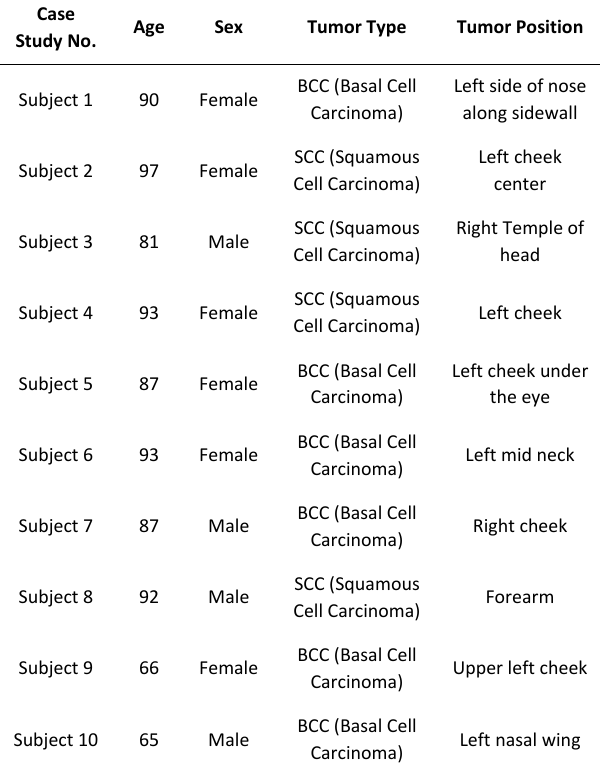
Table 1: Case studies recruited for testing the proposed method